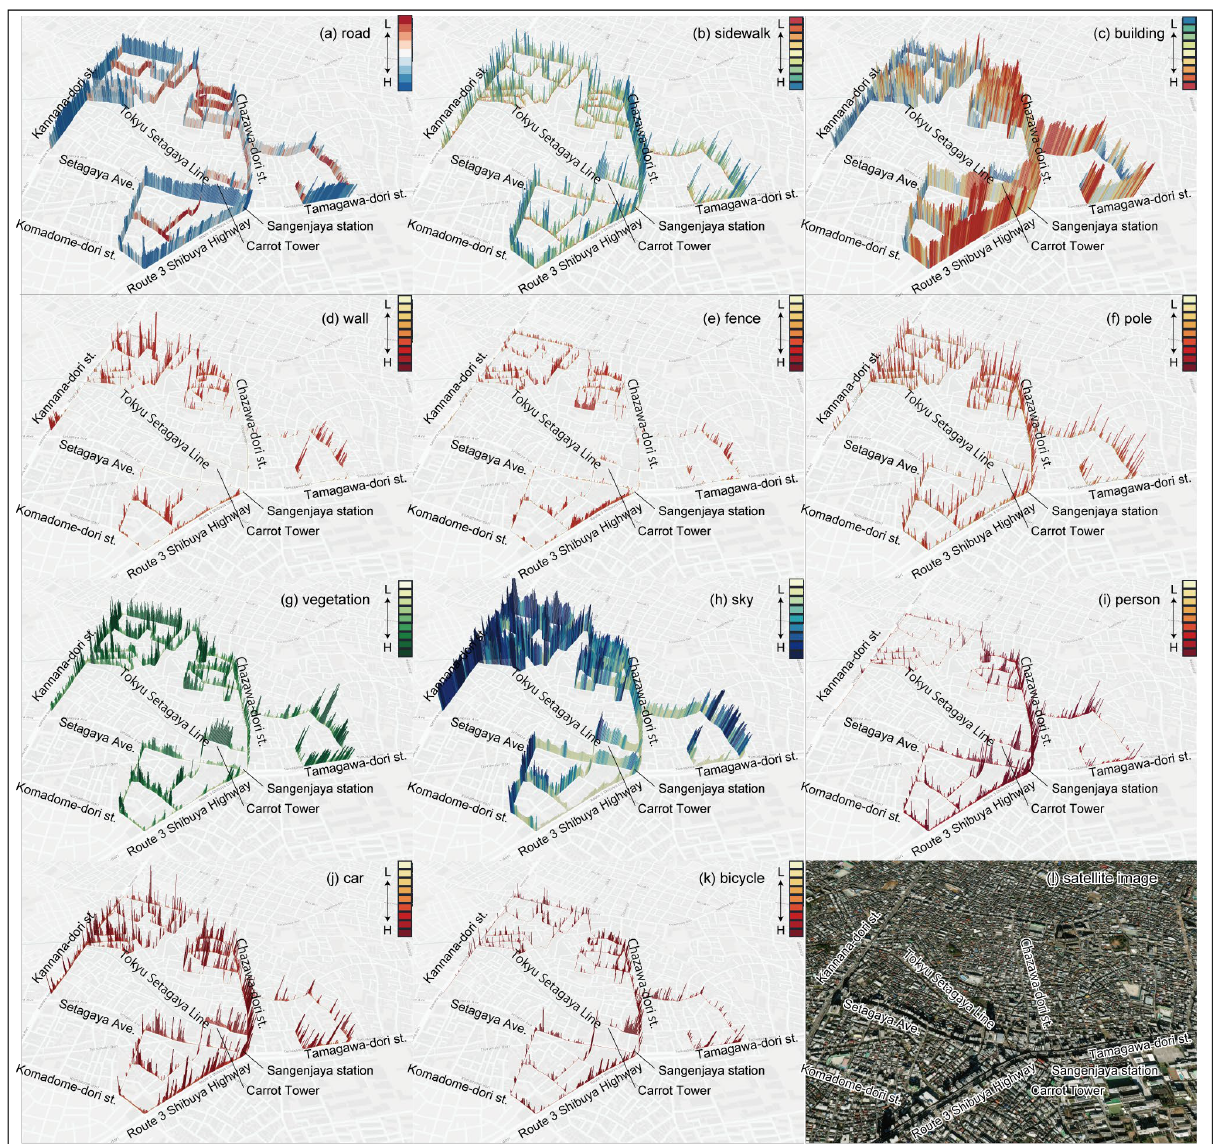
Figure 8. Visualization of street features by semantic segmentation. The length and colour of the bars represent the percentage of each